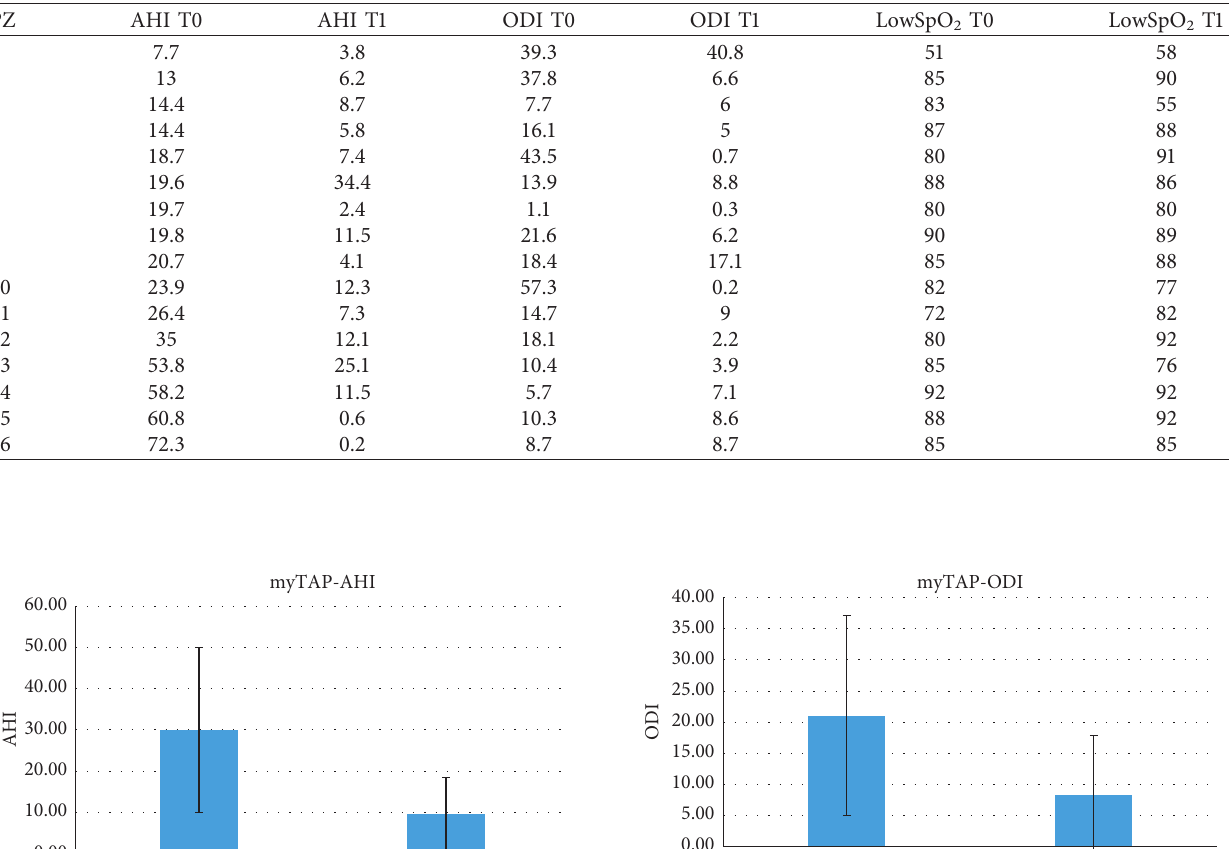
Table 3: Short-term effects of the myTAP ™ device on respiratory variables.